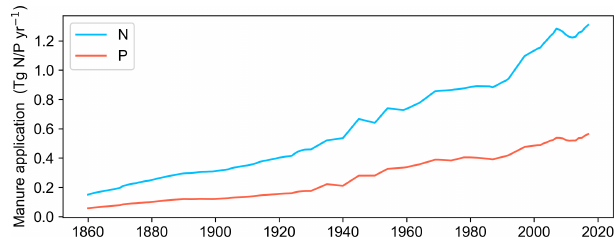
Figure 6. Trend and variations in total manure N and P application in the contiguous US from 1860 to